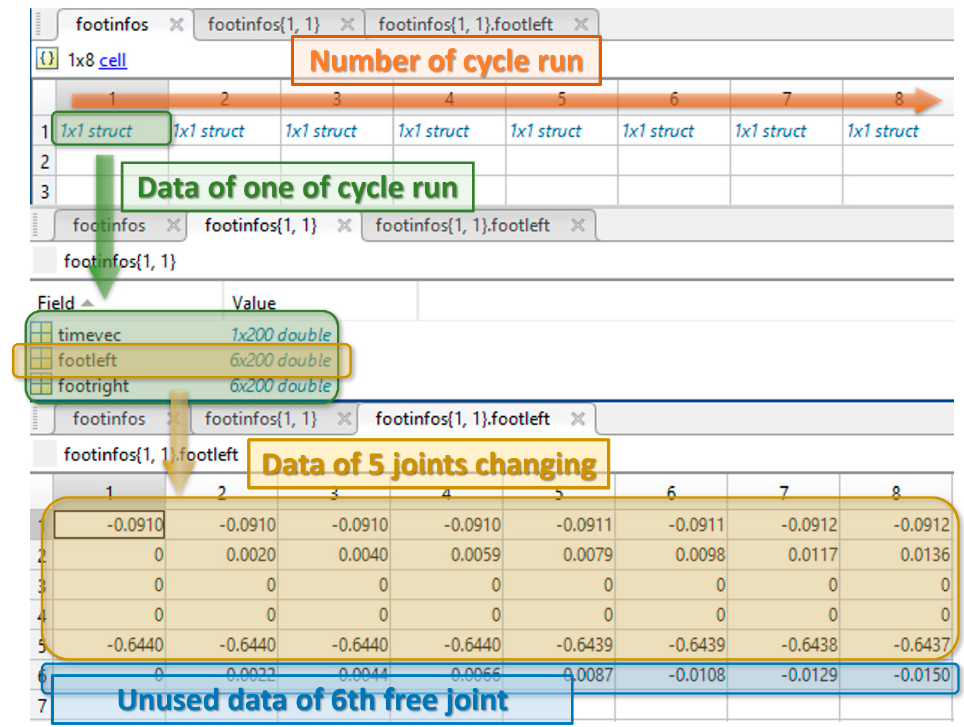
Figure 9. Data-structure covering the changes of DH parametrization in kinematic, 3D and simula- tion